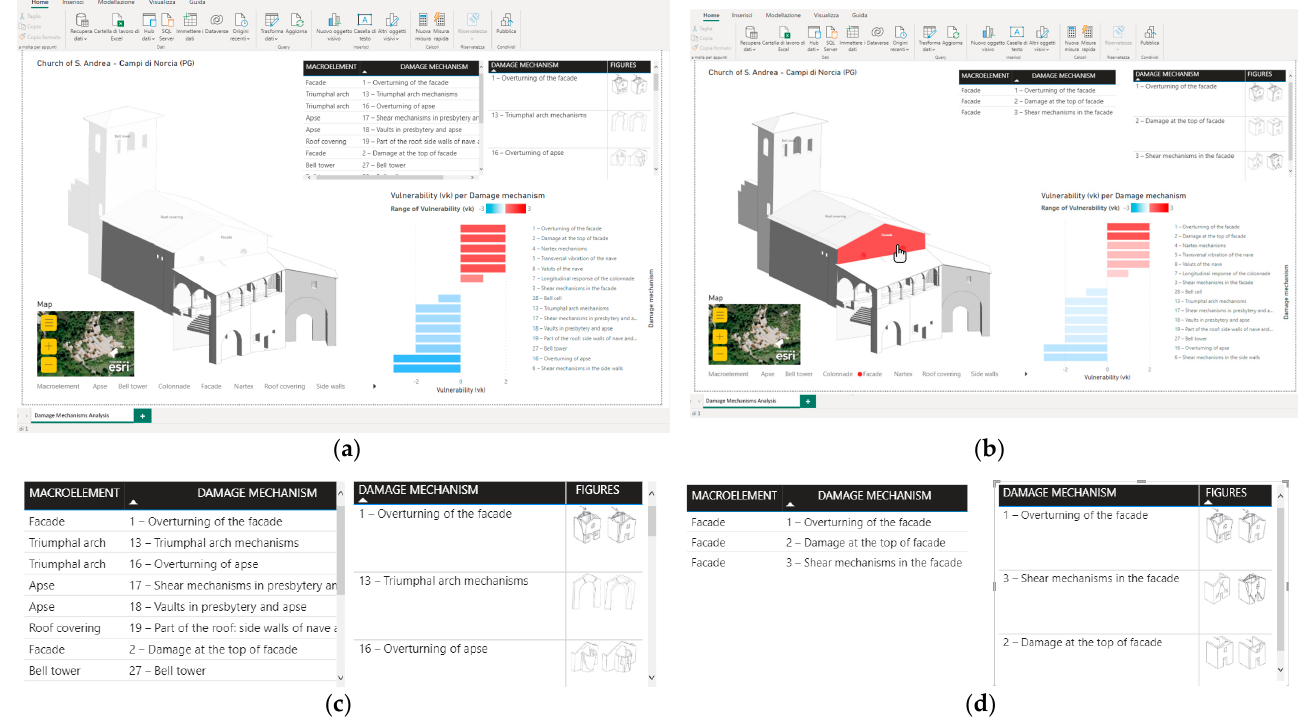
Figure 19. Thematic and interactive dashboard of S. Andrea’s Church damage mechanism: ( a ) general view with active tools, and ( b ) query of the façade element. In ( c , d ) respective zoomed view of the data reporting on the dashboard.